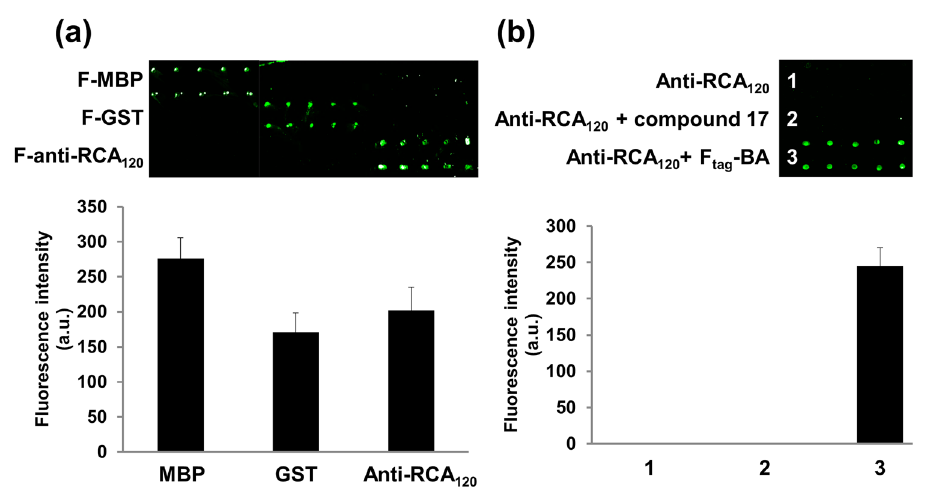
Figure 6. Fluorous protein microarray for the simultaneous detection of multiple proteins. ( a ) MBP, GST, and anti-RCA 120 were printed on a fluorous slide. ( b ) Confirmation of the specific fluorous-fluorous interactions. Anti-RCA 120 , anti-RCA 120 pre-incubated with F tag -acid (compound 5), and anti-RCA 120 pre-incubated with F tag -BA (compound 2) solutions were spotted on a fluorous